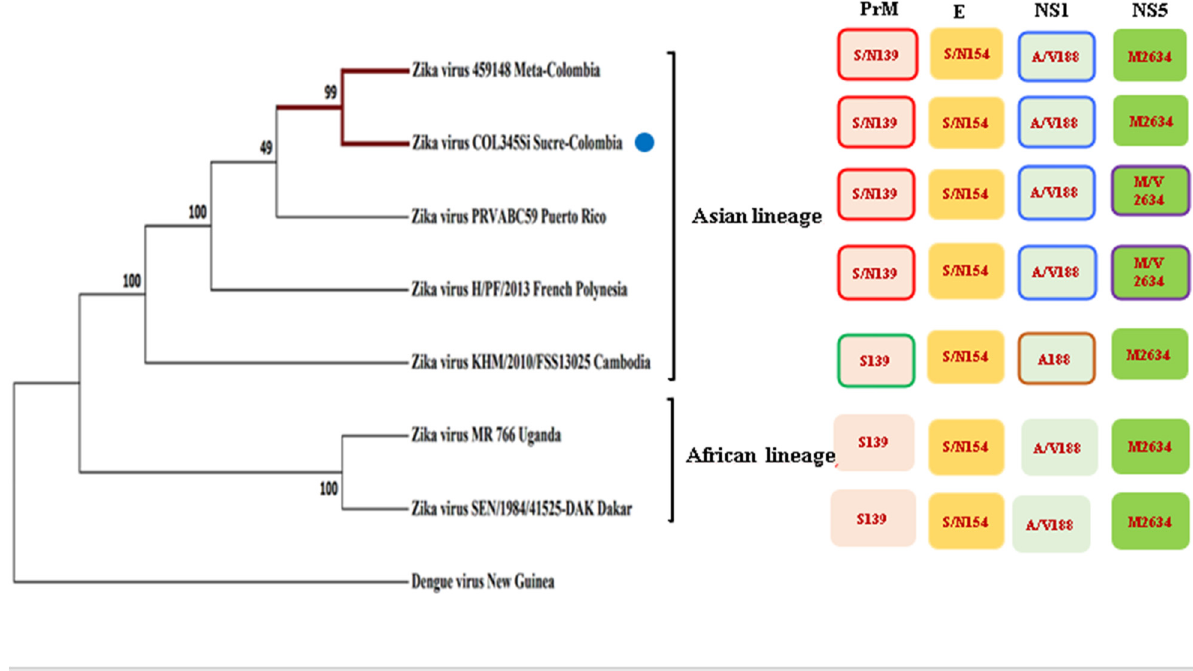
Figure 1. Phylogenetic tree of several strains of the Zika virus in comparison with the Zika isolated COL354Si GenBank: MH179341.1 (indicated with a blue point) showed similar mutations to the other Asiatic strains.